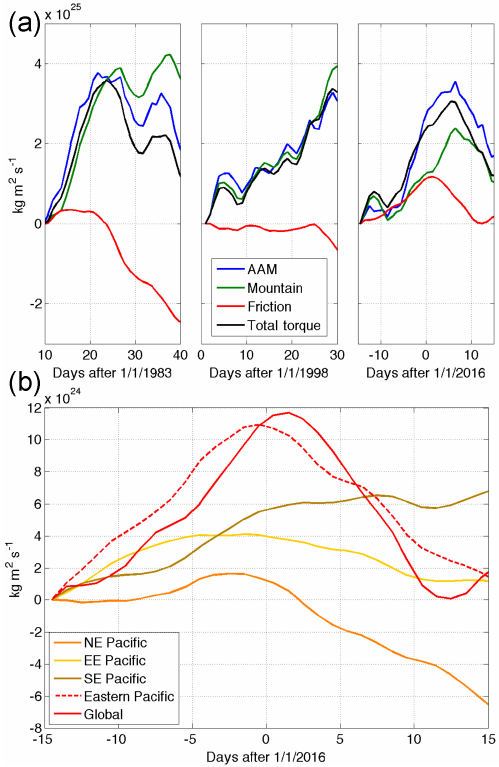
Figure 4. (a) The integrated torques compared to AAM during the three events and (b) the integrated friction torque with contribution from the different regions of the Pacific Ocean during the 2015– 2016